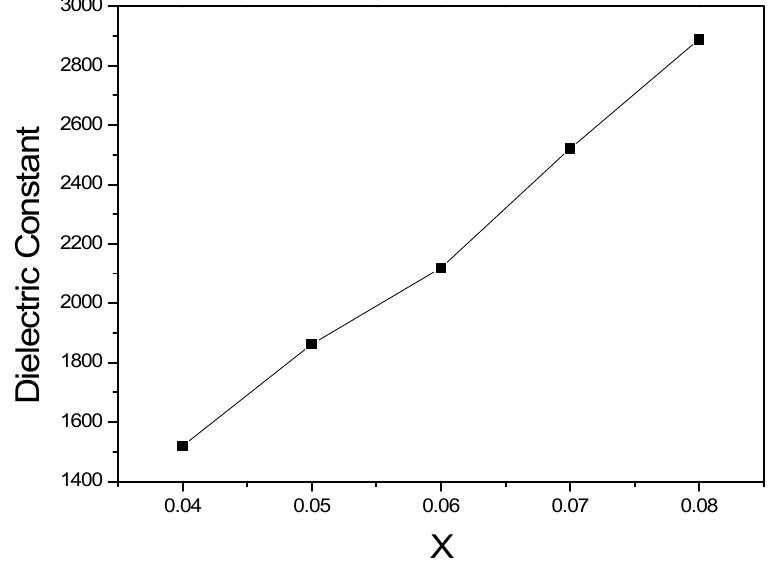
Figure 7. Dielectric constant ( ε r ) of samples with the amount of antimony.